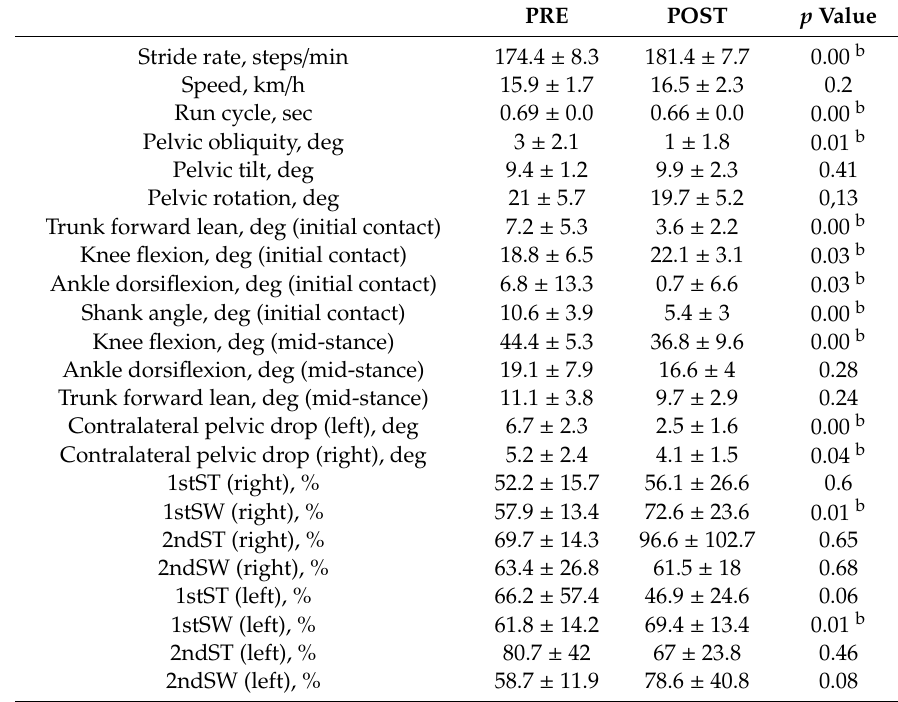
Figure 2. Importance of the variables, scaled according to the “varImp” method in the caret R library for the complete data set. Table 3. Analysed variables a